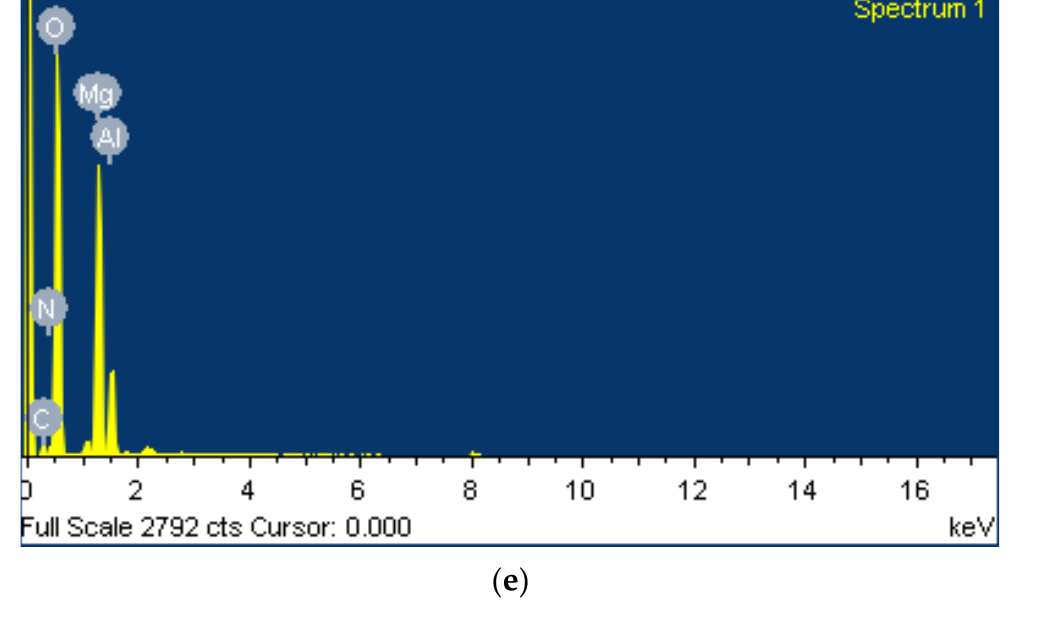
Figure 3. Results from ( a ) FESEM analysis of uncalcined LDH; ( b ) FESEM analysis of LDH calcined at 250 °C; ( c ) FESEM analysis of LDH calcined at 500 °C; ( d ) FESEM analysis of Degussa P25 TiO 2 nanoparticles; ( e ) EDX analysis of uncalcined LDH.